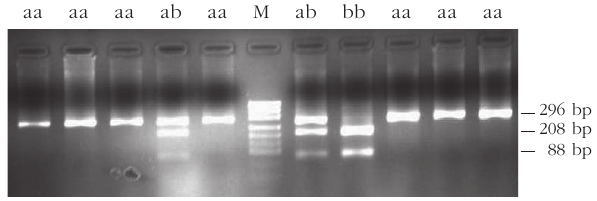
Fig 5 – Electrophoretic patterns of the second exon of Ovar- DRB 1 digested with Sac II in Kazakh sheep, M: puc19 DNA marker.